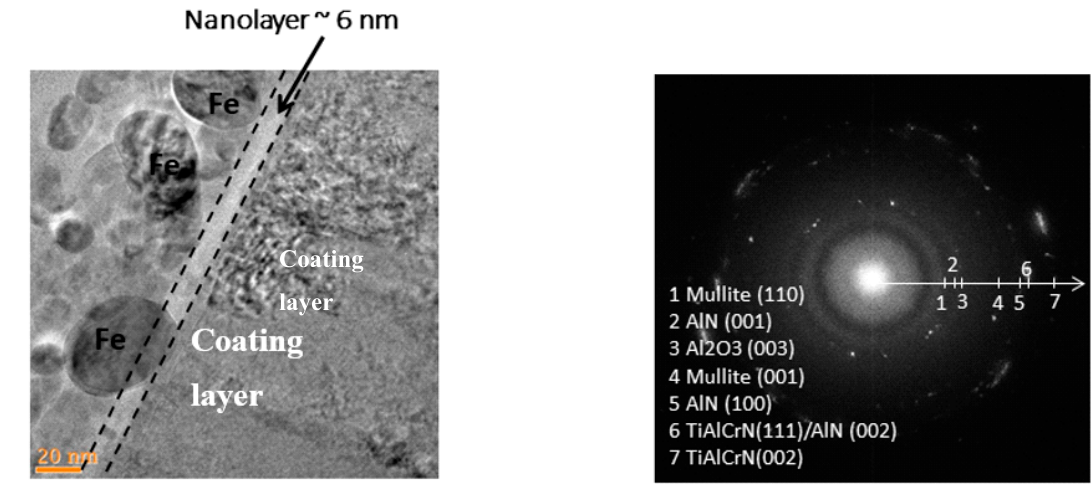
Figure 5. High resolution TEM image of the Focussed ion beam (FIB) cross-section with selected area electron diffraction (SAED) pattern insert of the worn surface, 15 m length of cut: Nano-layer of tribo-films on the surface of TiAlCrSiYN / TiAlCrN coating (6 nm thick)